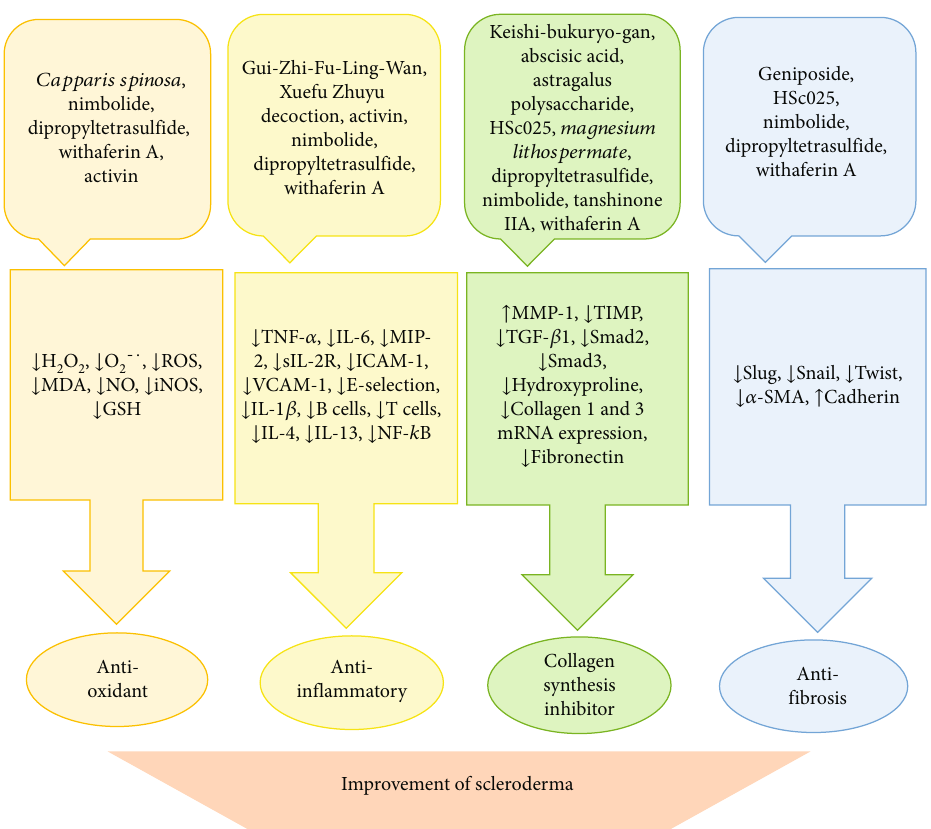
Figure 3: Mechanisms of action of herbal formulations and natural product for scleroderma treatment. Table 1: In vitro , in vivo , and clinical interventions of medicinal plants for scleroderma treatment. Herbal species and/or formulation Type of study Outcomes Reference In vitro Capparis spinosa L.